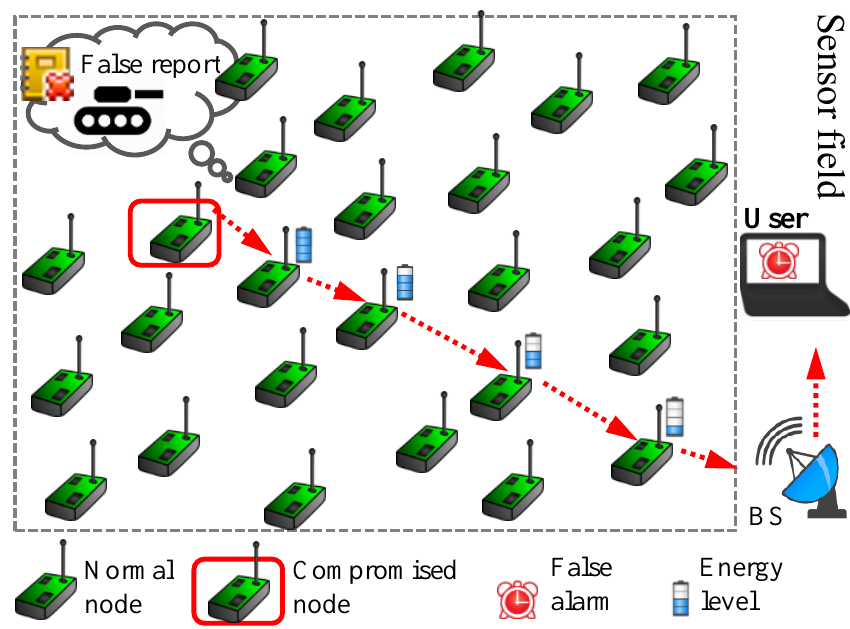
Figure 1. False report injection attack in wireless sensor